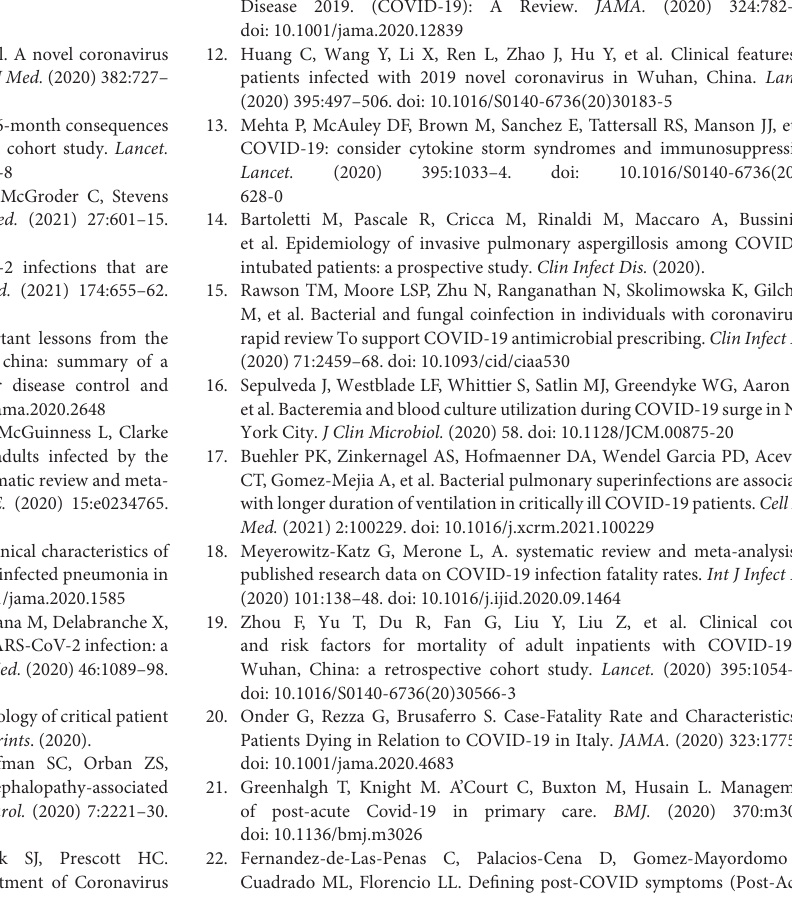
Supplementary Figure 1 | Details of Figures 2C,D (cerebral tissue from basal ganglia). Inset 1: Luxol-stain demonstrates myelin loss (magnification 25 x). Inset 2: immunostaining for NF70/200 (magnification 25 x) demonstrates loss of axons: as such, myelin loss should be interpreted as secondary to infarction and not as demyelination. Inset 3: Luxol-stain in a control case from the same anatomical region (basal ganglia) without myelin loss. Inset 4: immunostaining for NF70/200 in a control case from the same anatomical region (basal ganglia) without loss of axons. Supplementary Figure 2 | Comparison between morphologic findings and positivity of postmortem swabs in the corresponding organs. The patients are ordered from up to down in a crescent pattern based on the number of days between diagnosis of COVID-19 through nasopharyngeal swab and death. Interpretation: green = finding present with positive swab; blue = finding present with negative swab; red = finding absent with positive swab; black = finding absent with negative swab. NA, not available; DAD, diffuse alveolar damage; BP, bacterial pneumonia; LA, lung aspergillosis; MiT, microthrombi; MaT, Macrothrombi; LH, lung hemorrhages; LI, lung infarcts; MI, myocardial